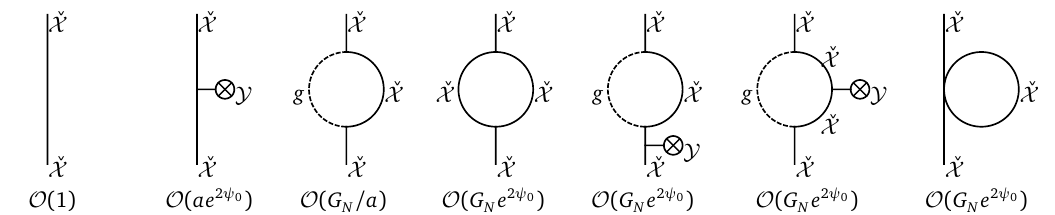
Figure 1: Leading diagrams (up to one loop) contributing to the two-point function, by order of relevance. Notice that the last four loop diagrams contribute at the same order, and we have included the loop correction due to a quartic interaction.